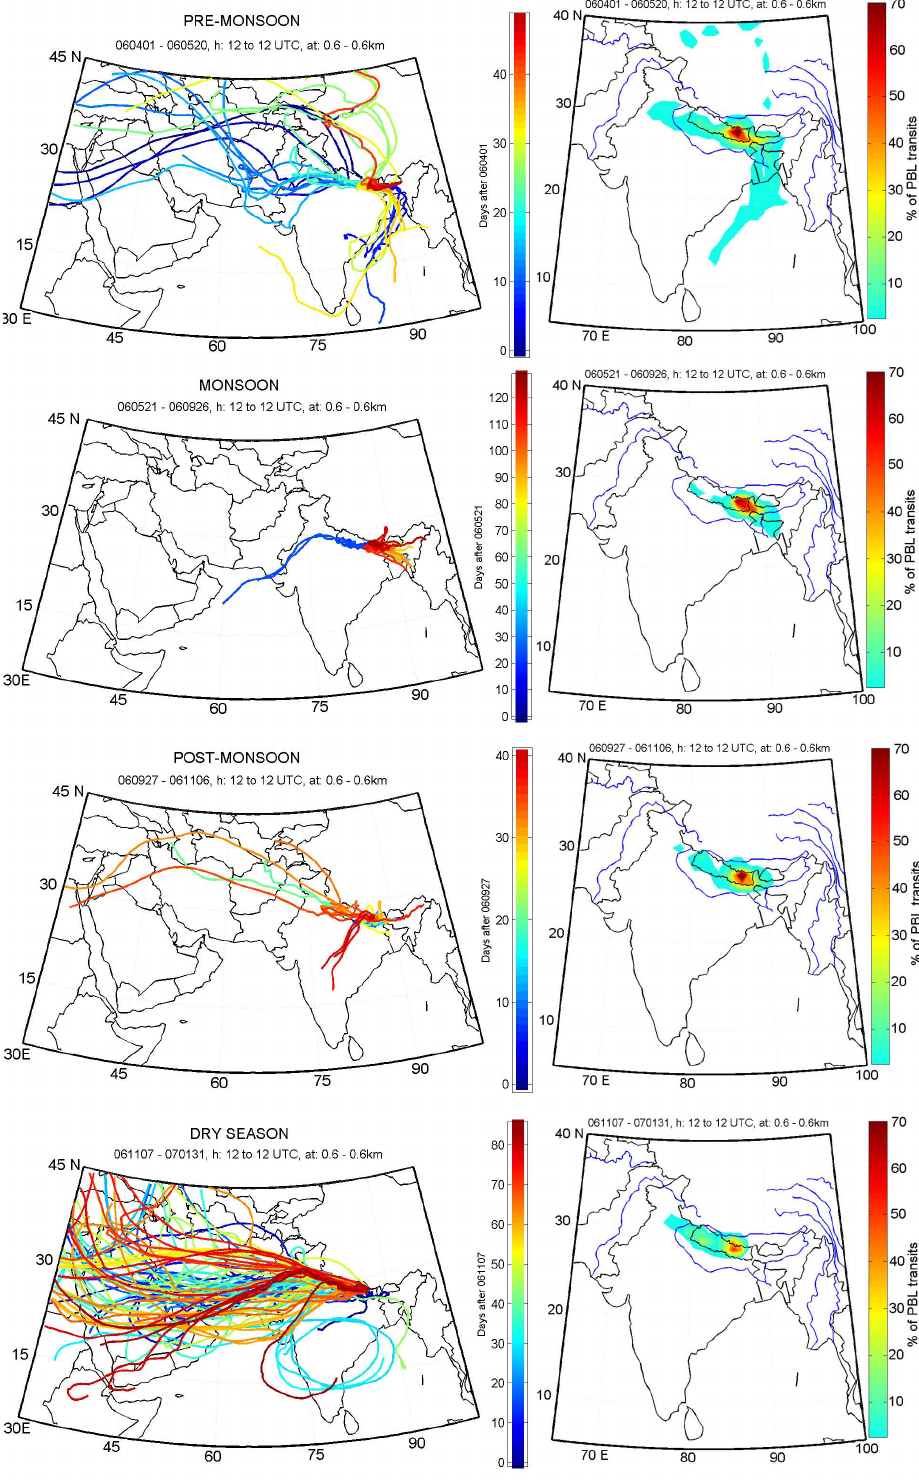
Fig. 2. Left column: daily patterns (colour-coded time scale) of back-trajectories ending at 12:00UTC, 600m above NCO-P during the 2006– 2007 pre-monsoon, monsoon, post-monsoon, and winter season periods (first to fourth row, respectively). Right column: corresponding contour plots of the back-trajectories origin density (evaluated as percent of trajectory transits in the local